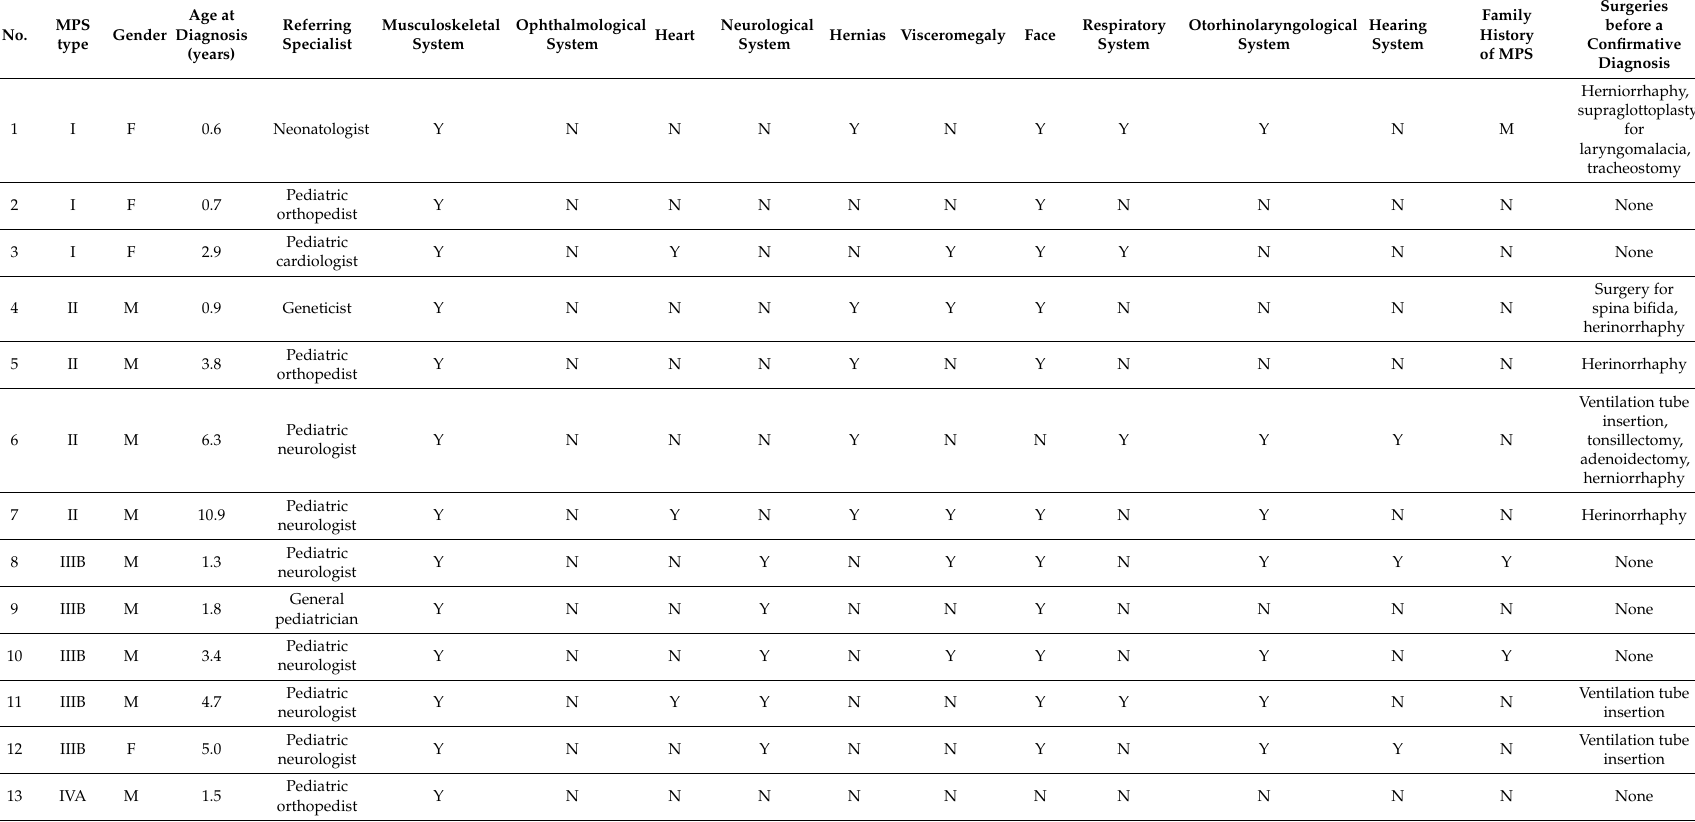
Table 5. Clinical characteristics of the 13 MPS patients at the time of a confirmative